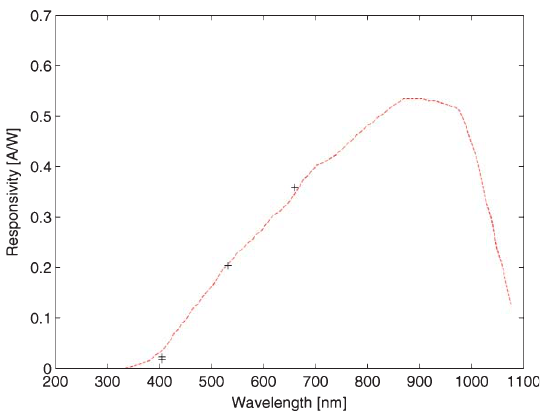
Fig. 13. The optical correction factor showing the jaw position dependence on the percentage of light received by the photodiode.